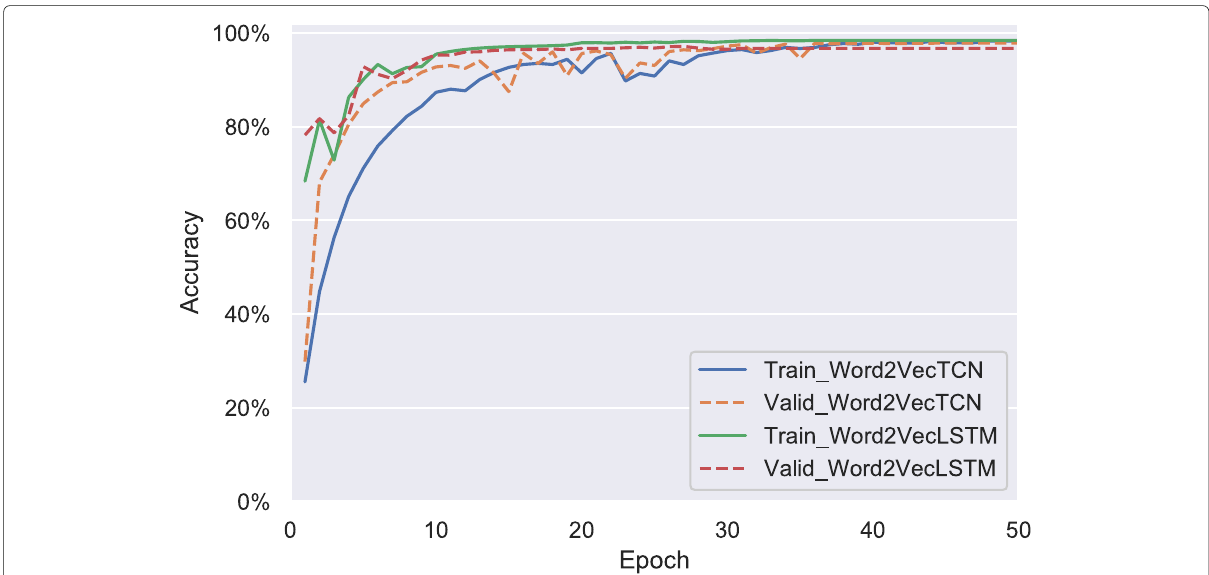
Fig. 10 The accuracy comparison between the state-of-the-art approach and our proposed